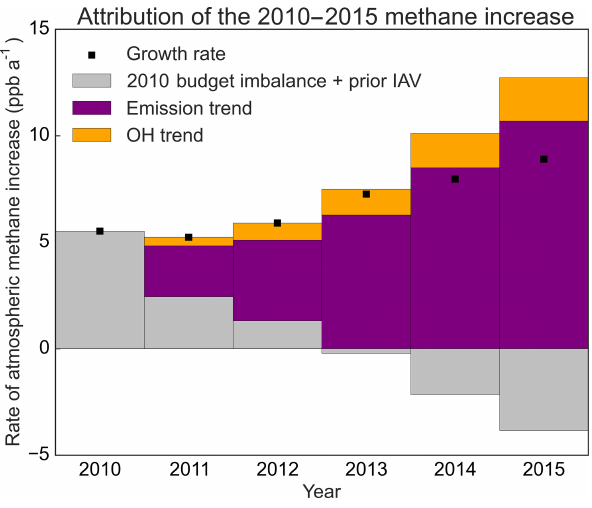
Figure 10. Attribution of the 2010–2015 increase in the atmo- spheric burden of methane. The grey bars show the trend imposed by the 2010 imbalance between sources and sinks combined with the interannual variability (IAV) of the prior estimate (mainly from wetlands). This trend decreases over the 2010–2015 period because the methane sink rises in response to the increasing methane con- centration and also because wetland emissions in 2010 are higher than in other years. Purple and orange show the contributions of the 2010–2015 methane emission trends and OH trends. The appor- tionment of the emission trend by source region and source type is shown in Fig. 7. The OH trend has high uncertainty as discussed in the